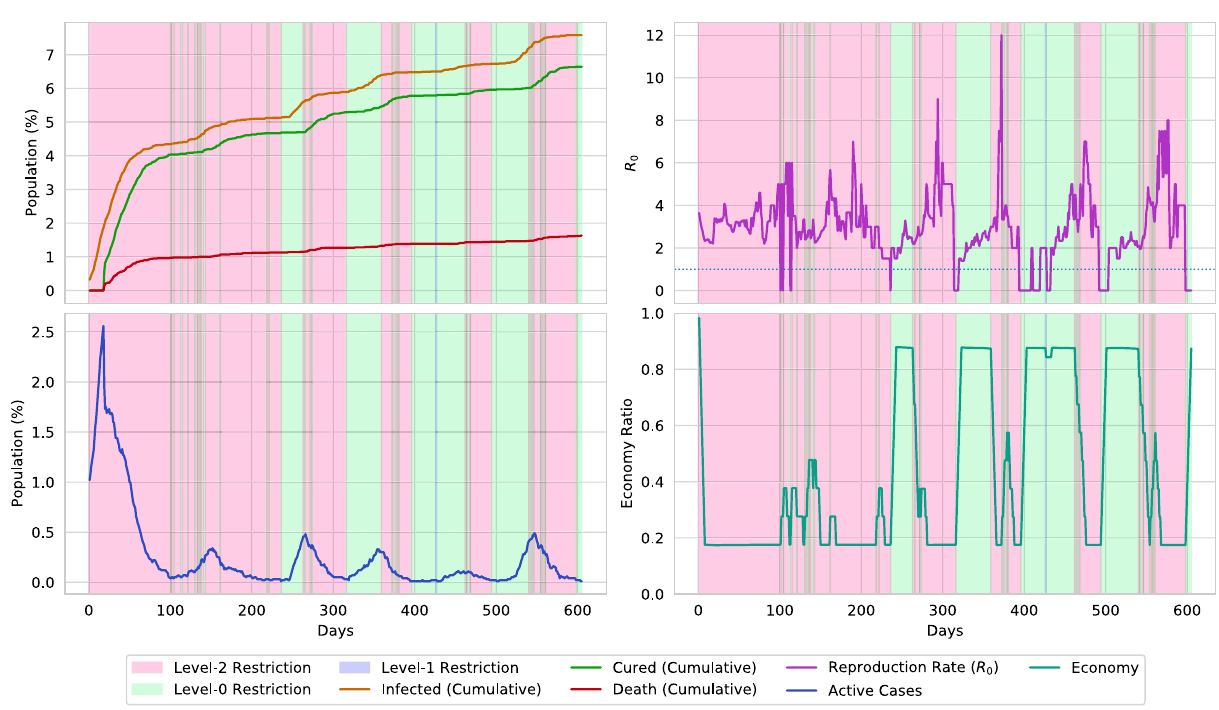
Figure 21. This graph illustrates the actions performed by the agent in a 0.03 population density environment. The other environmental parameters are kept unchanged. The graph resembles a similar action pattern of the agent observed in a 0.02 population density environment. However, due to increased population density, the spread of disease is also increased. Therefore, the agent mostly places strict lockdown instead of cyclic